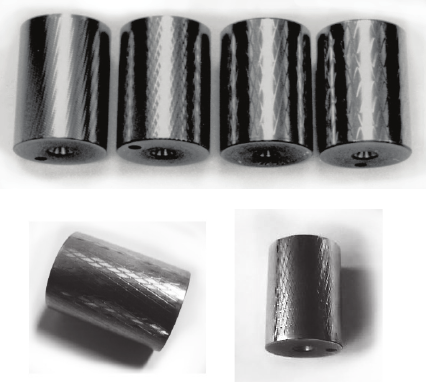
Figure 6. Textured specimens with various relative area of